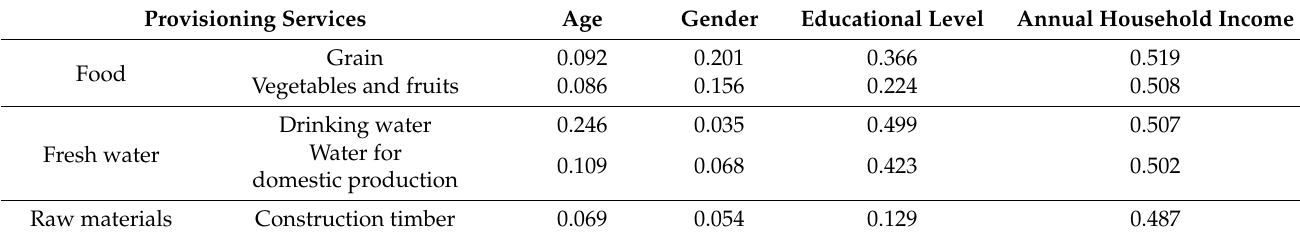
Table 10. Cramer’s V value of the correlation between perception of provisioning service and individual